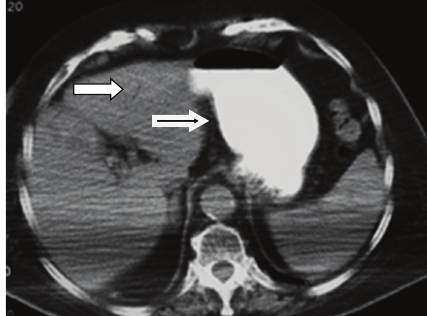
Figure 2: Small arrow showing the presence of air in an intrahepatic bile duct. Large arrow showing gastric dilatation.